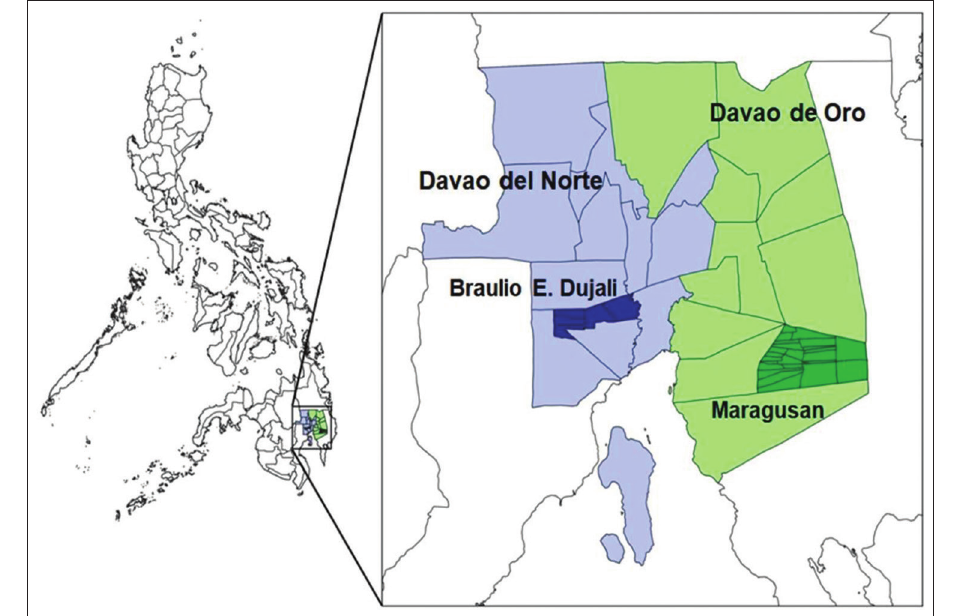
Figure-1: Map of the Philippines (left) and provinces of Davao del Norte and Davao de Oro (right) showing the selected municipalities [Source: Map generated using free and open-source QGIS software version 3.1.6]. Table-1: Prevalence of helminths in water buffaloes by formalin-ethyl acetate sedimentation technique in selected municipalities, Braulio Dujali, Davao del Norte and Maragusan, Davao de Oro, the Philippines, September 2019. Parasite Municipality